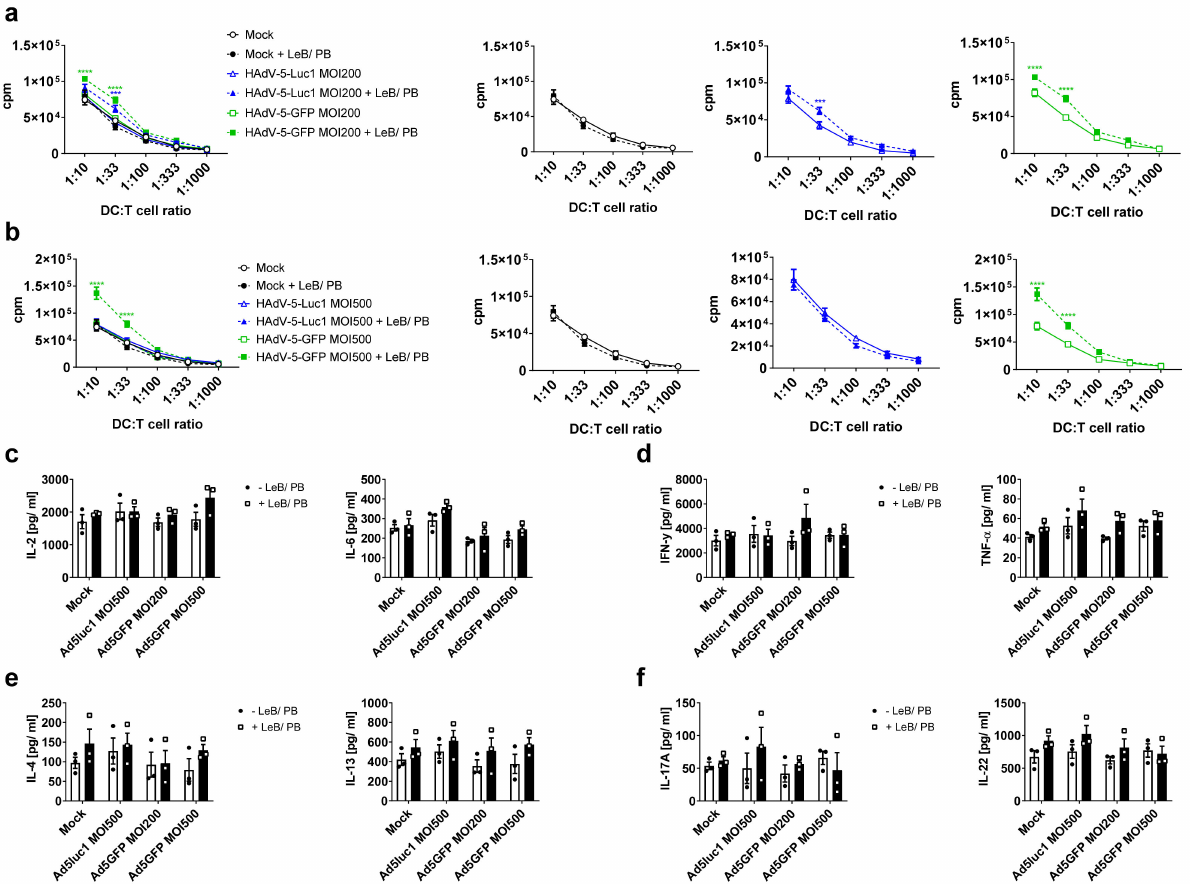
Figure 3. HAdV-5-transduced mBMDCs in combination with LentiBOOST ® /Polybrene retain their function. LPS-matured BMDCs were transduced with HAdV-5-Luc1 or HAdV-5-GFP at an MOI of 200 or 500 in combination with LentiBOOST ® /Polybrene (+LeB/PB) or water ( − LeB/PB). Forty- eight hours afterwards, cells were assessed using an allogeneic mixed lymphocyte reaction assay. ( a , b ) Allogeneic mixed lymphocyte reactions (MLRs) of mBMDCs transduced at MOI200 ( a ) or MOI500 ( b ). Cells were co-cultured with BALB/c derived spleen cells at the indicated ratios for 72 h, before pulsing with 1 µ C/well [H3]-thymidine. Thymidine uptake was assessed using a 1450 MicroBeta counter. ( c – f ) Cytometric bead array (CBA) of MLR-derived cell culture supernatants. Cell-free supernatants of the DC-T cell co-cultures described in ( a , b ), were collected at day 3 before pulsing with thymidine and stored at − 20 ◦ C. Content of cytokines was determined by cytometric bead array. ( a – f ) Data are mean ± SEM of three independent experiments with cells derived from different mice. Black circles represent conditions without LentiBOOST ® /Polybrene, white squares represent conditions with LentiBOOST ® /Polybrene.Two-way ANOVA and Sidak correction were performed. *** p < 0.001, **** p < 0.0001, bars without annotation are not significant ( p > 0.05) in comparison to the respective condition